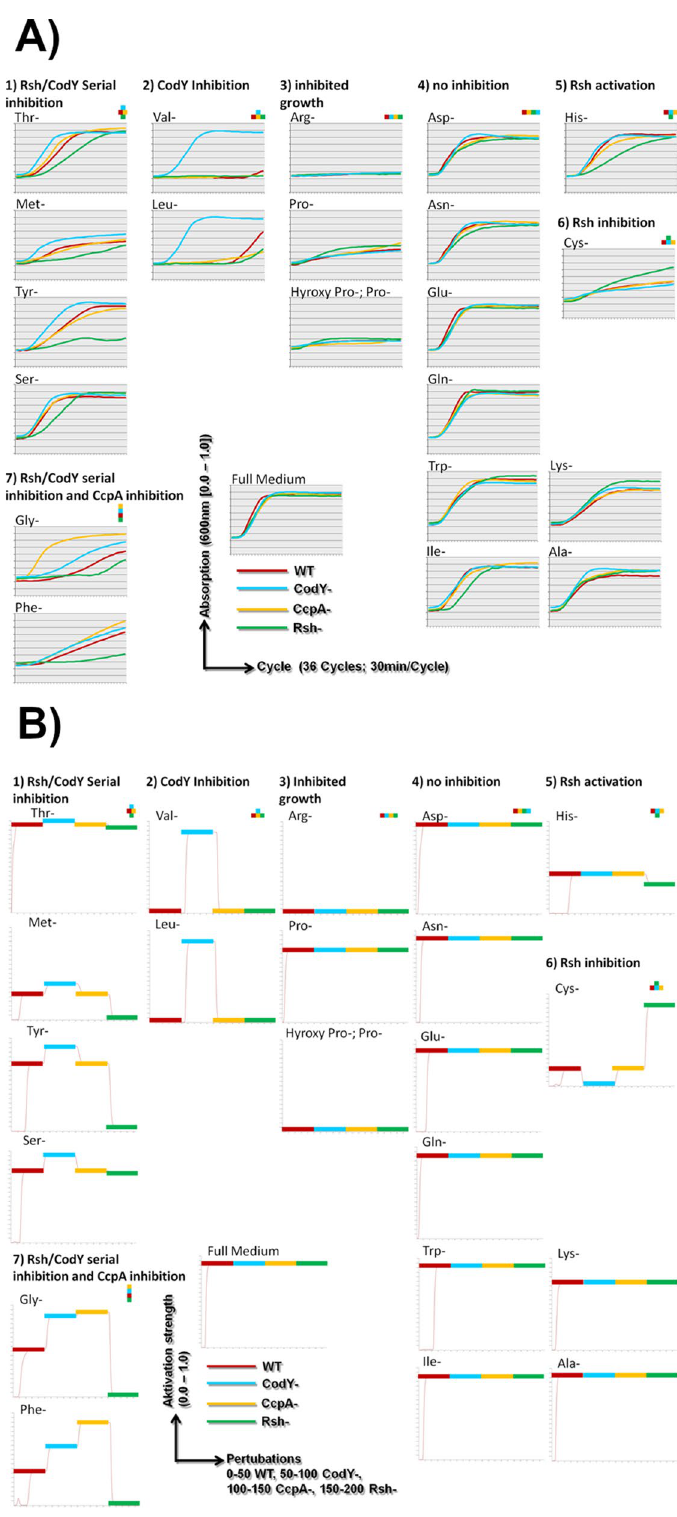
Figure 1. Seven patterns how AA-Synthesis depends on central nodes: Each pattern is introduced with its specific regulator pattern. Here the different in vitro growth curves ( A ) are shown (control, bottom middle: growth in complete medium) and compared to the in silico results ( B ). The phenotype of the in vitro growth as surrogate parameter for the synthesis of the deprived AA is compared to the in silico simulated AA synthesis phenotypes. Shown on the X-axis in ( A ) is the temporal course (30 min/growth step) and in ( B ) are the set perturbations (0–50 = WT, 50–100 = CodY-, 100–150 = CcpA-, 150–200 = RSH-) (Jimena version 26.02.2015; https:// www. bioze ntrum. uni- wuerz burg. de/ bioin fo/ compu ting/ jimena/ 22 . The different mutants are color-coded: red = WT, blue = CodY-, light brown = CcpA-, green = RSH-. For each condition, exactly one simulation is given. The simulation reproducibly always yields the same result. For the growth experiments, on the other hand, three measurements were conducted for each growth condition. The simulations and the individual growth experiments are given in the detailed larger graphs in the supplementary